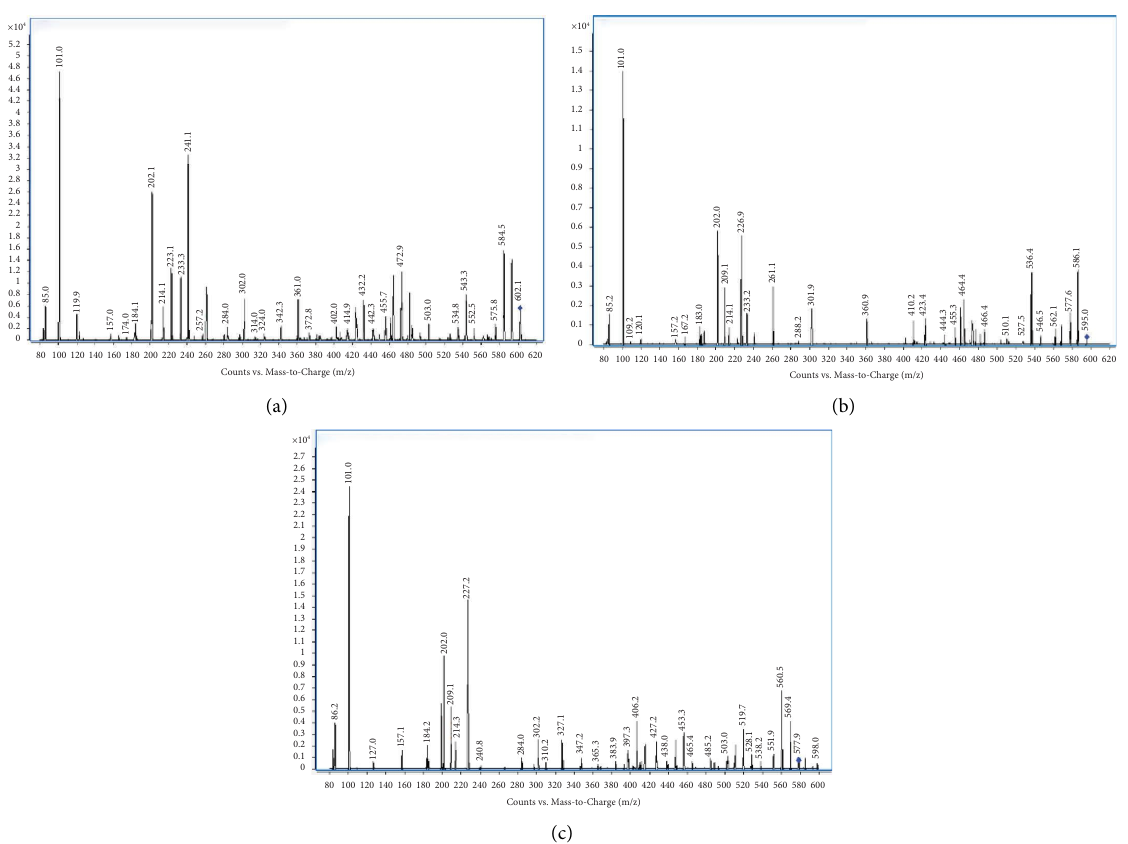
Figure 2: Te product iron scan of PB1/PB1-I (a), PB2/PB3 (b), and PE2 (c) showing fragmentation patterns of PB1/PB1-I, PB2/PB3, and PE2